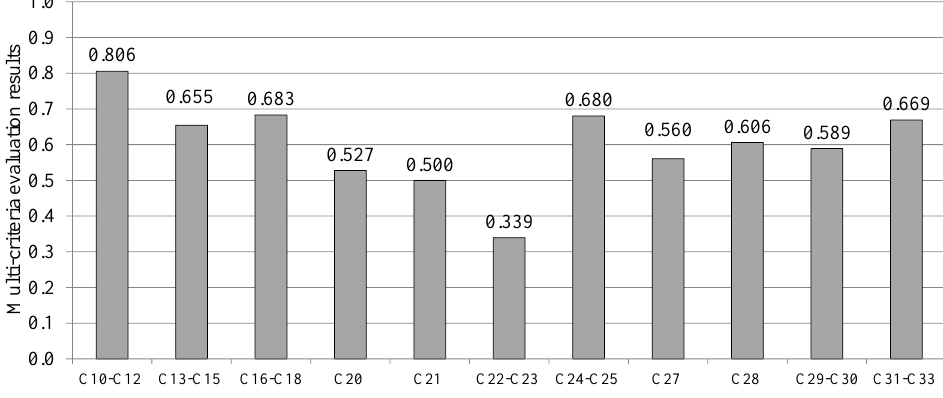
Fig. 4. Results of multi-criteria